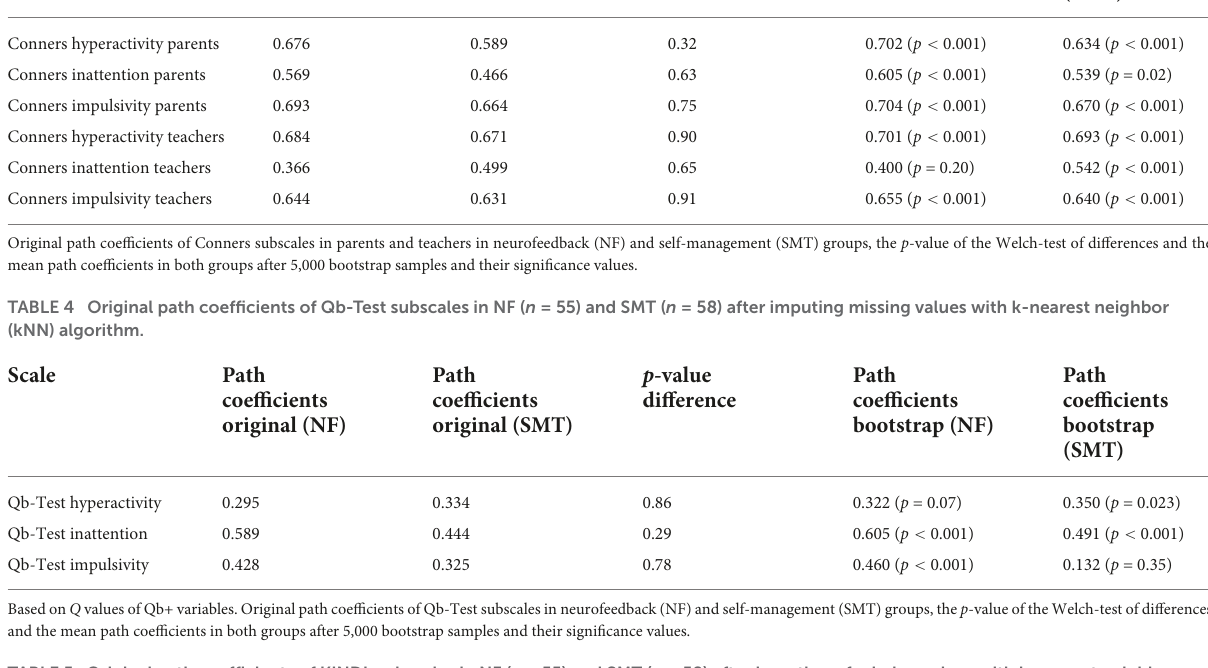
TABLE 5 Original path coefficients of KINDL subscales in NF ( n = 55) and SMT ( n = 58) after imputing of missing values with k-nearest neighbor (kNN)